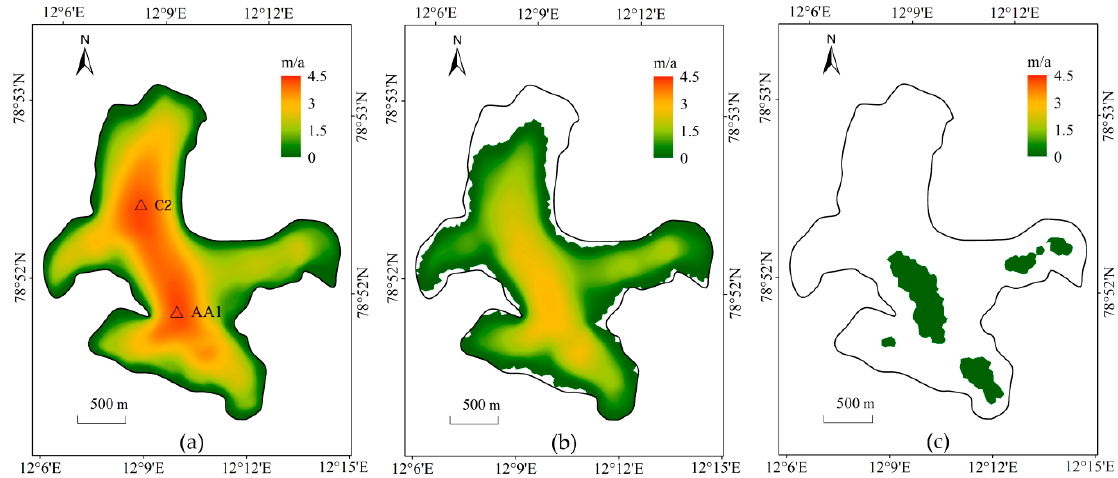
Figure 7. Simulated ice flow velocity field of AL under the high-probability scenario in 2010 ( a ), 2055 ( b ) and 2100 ( c ).